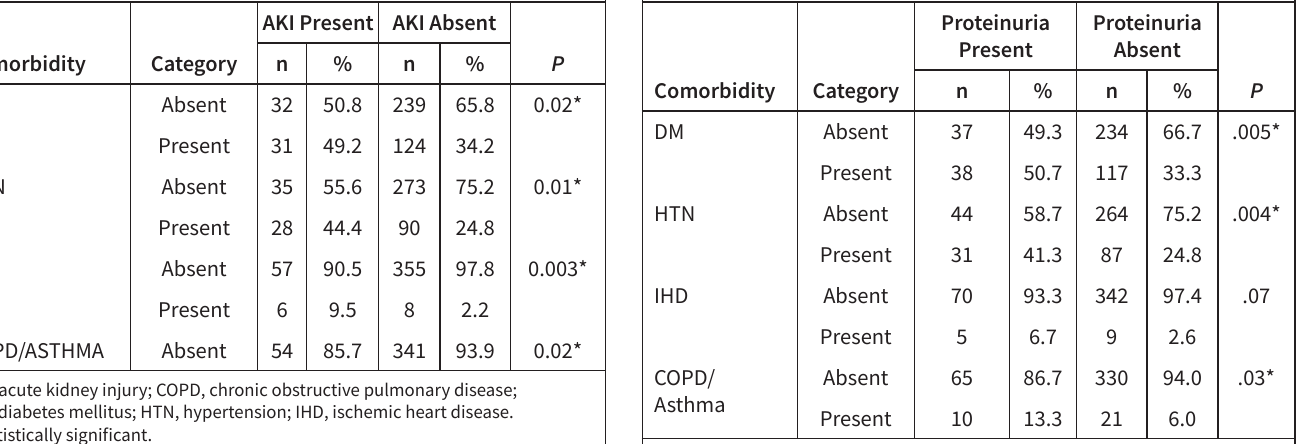
Table 6. Comparison of Presence of AKI with Comorbid Conditions of Patients Using Chi-Square Test